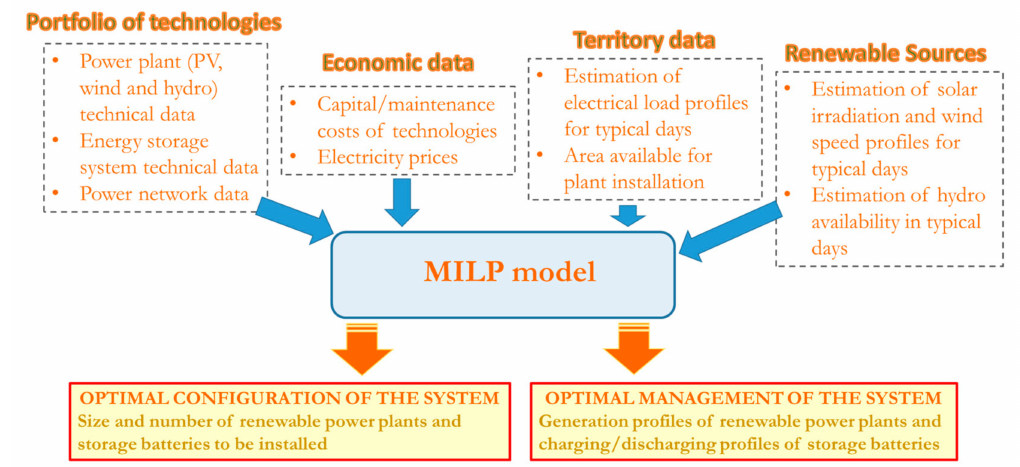
Figure 3. The architecture of the optimization